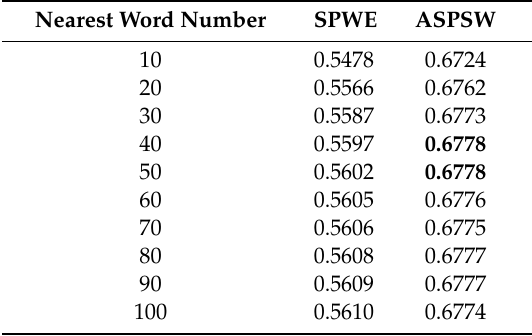
Table 4. Prediction accuracy of the SPWE and ASPSW models under setting di ff erent values of k;the best results are in bold-face.